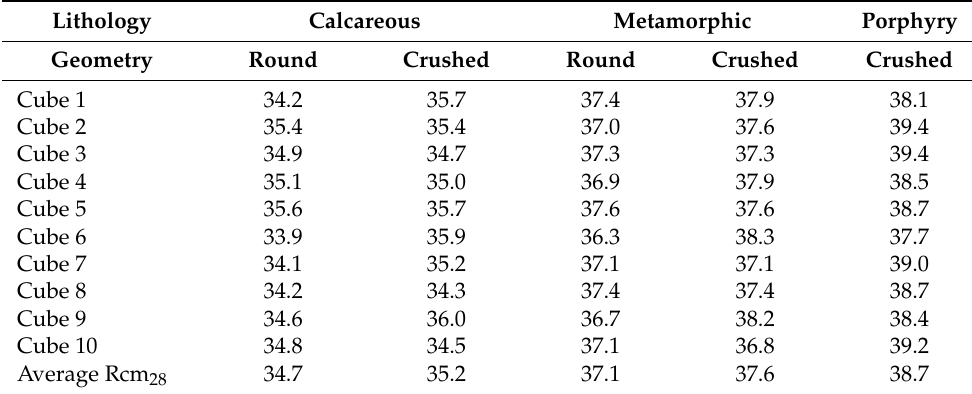
Table 16. Compressive strength values of each concrete cube after 28 days (Rcm 28 ) and expressed in N/mm 2